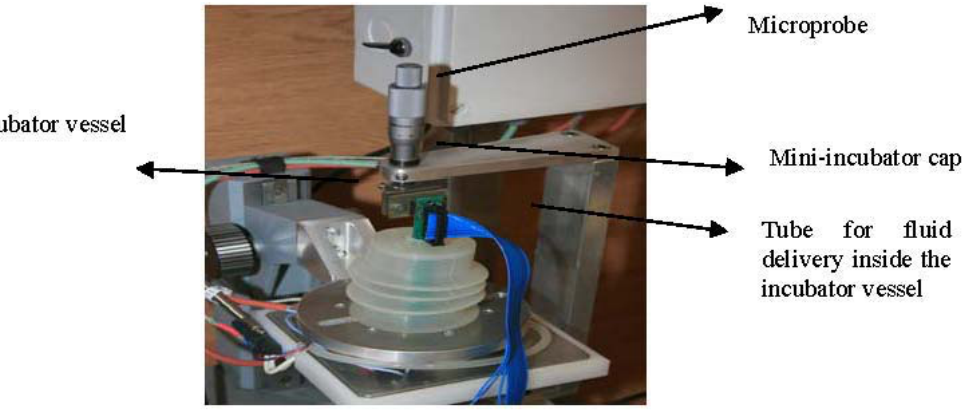
Figure 8. Mini-incubator for monitoring of cell